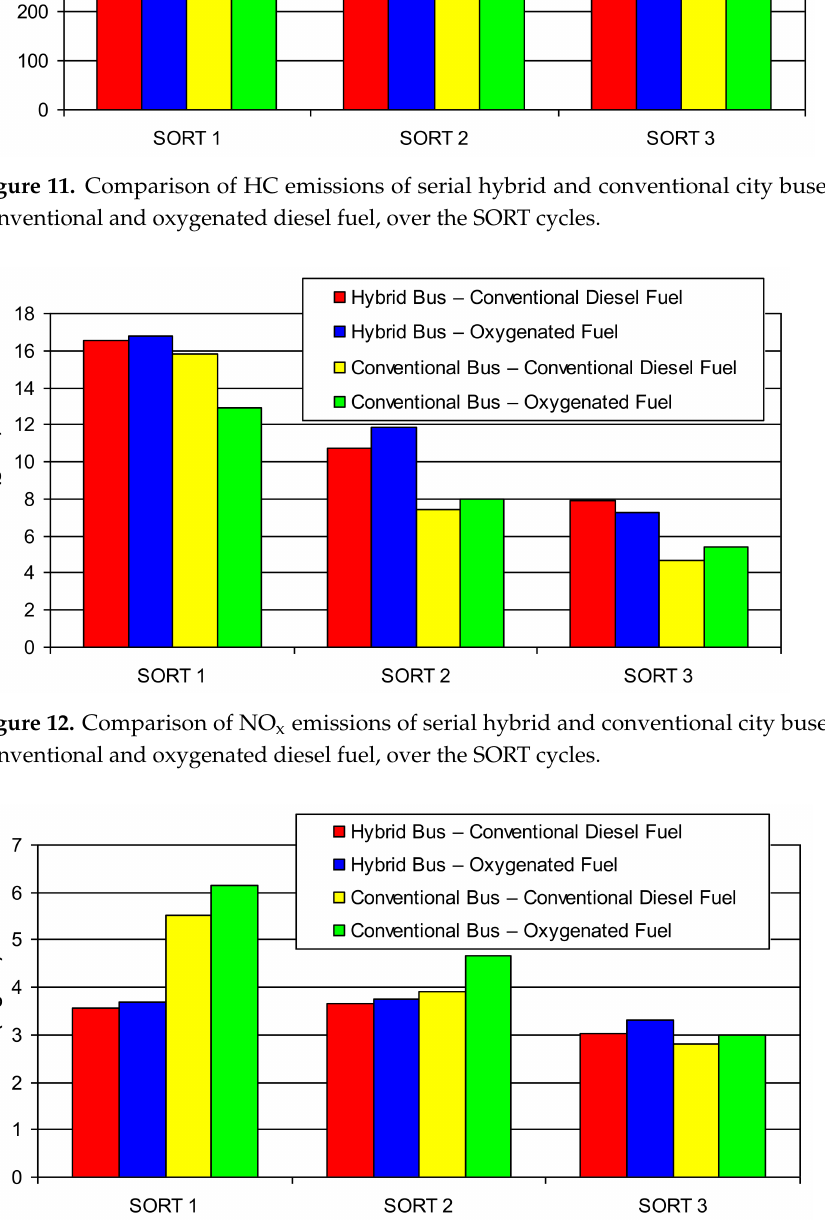
Figure 13. Comparison of PM emissions of serial hybrid and conventional city buses running on conventional and oxygenated diesel fuel, over the SORT